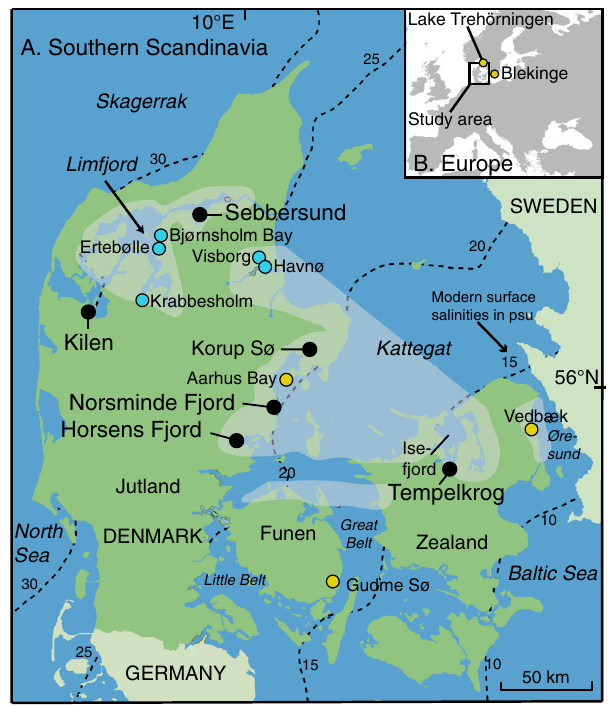
Fig. 1 Map of Denmark with location of the study sites (black dots). Shading indicates the distribution of middle and late Stone Age shell middens across >7300 km of coastline with key middens indicated (blue dots). Other important sites mentioned in the text are shown with yellow dots. Salinity contour lines based on Dahl et al. 64 annual temperatures ~2.5 °C 37 higher during its peak (ca.